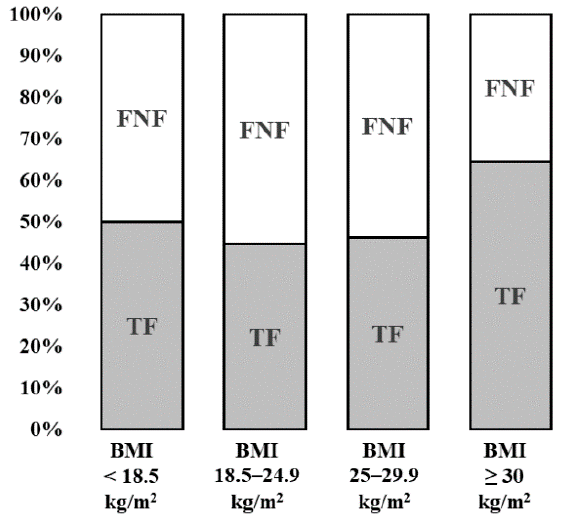
Figure 1. Ratio of femoral neck fractures (FNFs) to trochanteric fractures (TFs), depending on the body mass index (BMI) classification. Table 4. Complications and outcome variables.